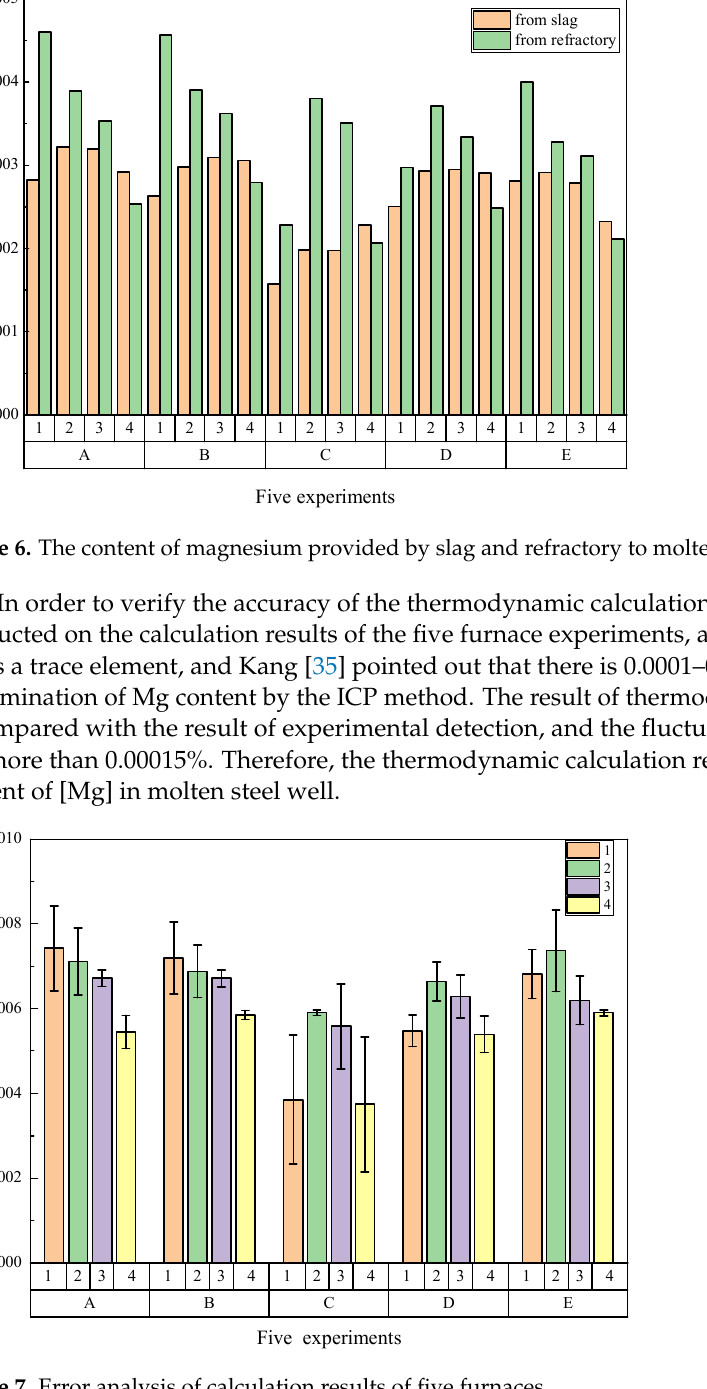
Figure 7. Error analysis of calculation results of five furnaces.